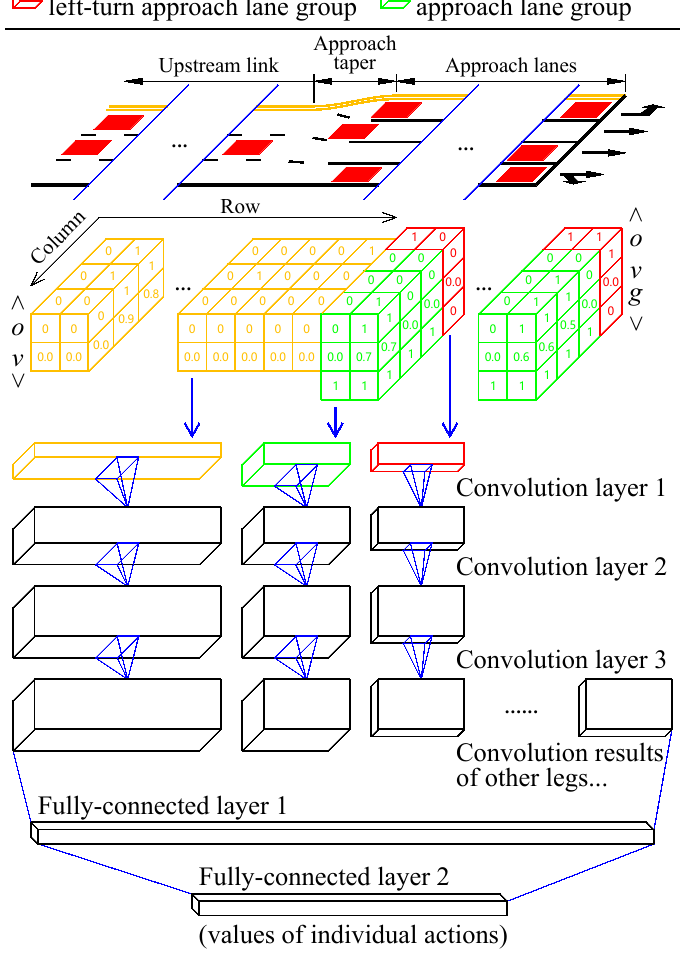
Figure 3. State representation and neural network structure. Similarly, the state features of the phase-unrelated grids on the b th intersection leg are